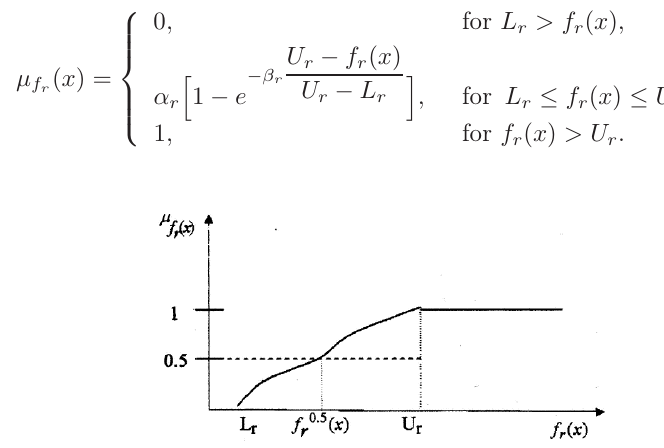
Figure 2. Exponential membership